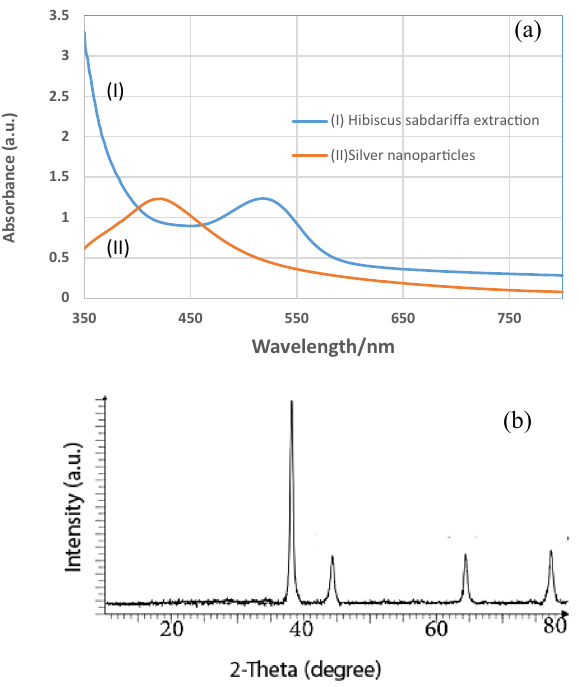
Figure 2. UV–Vis of the silver nanoparticles, UV–Vis of the Hibiscus sabdariffa extraction ( a ), XRD pattern of silver nanoparticles ( b ).